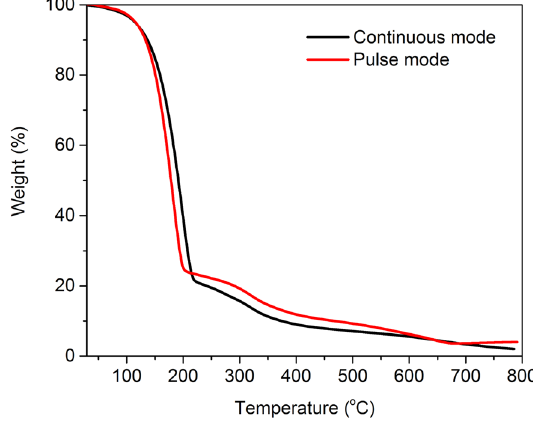
Figure 8: TG curves of BSA/AM microcapsules under di ff erent ultrasound